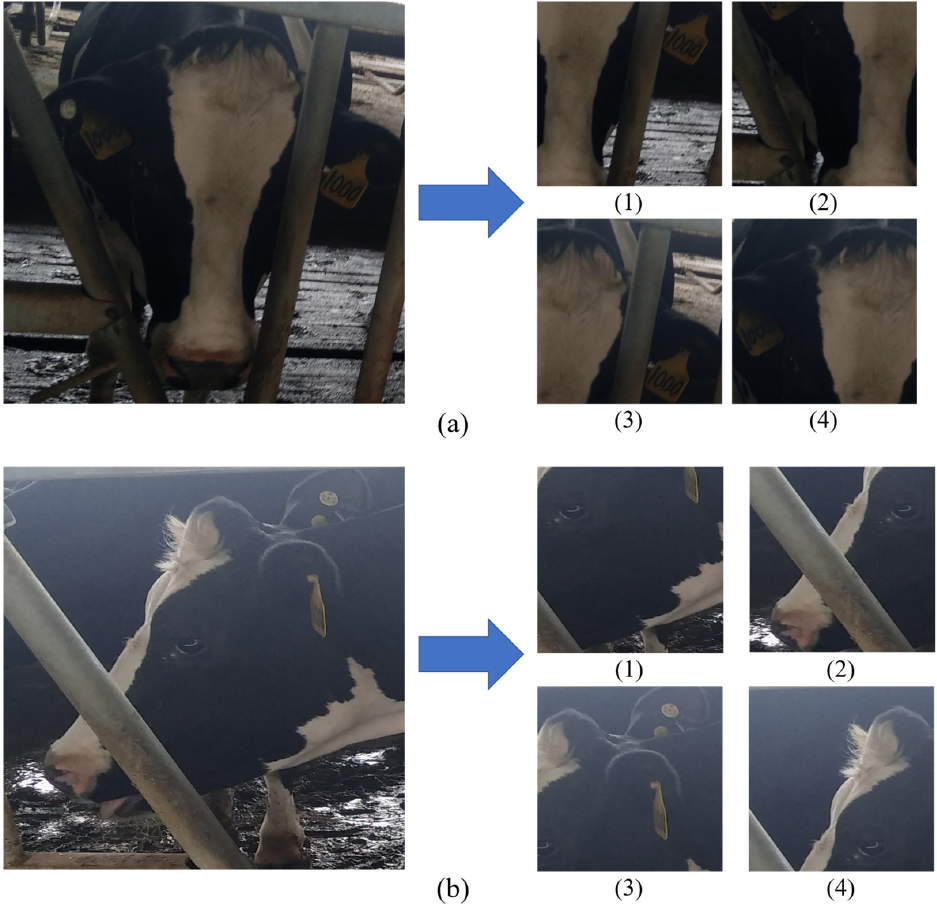
Figure 8. The visualization of failures in the extracted regions of the GPN-ST model. The left col- umns of ( a , b ) are the same cow with different angles. The right columns of ( a , b ) separately repre- sent the extracted the local regions with STN module.